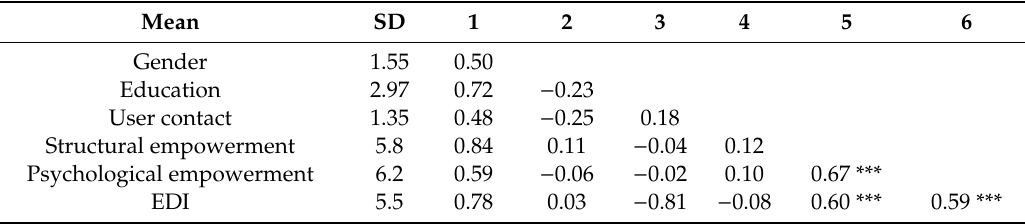
Table 3. Mean, Standard deviation and scale